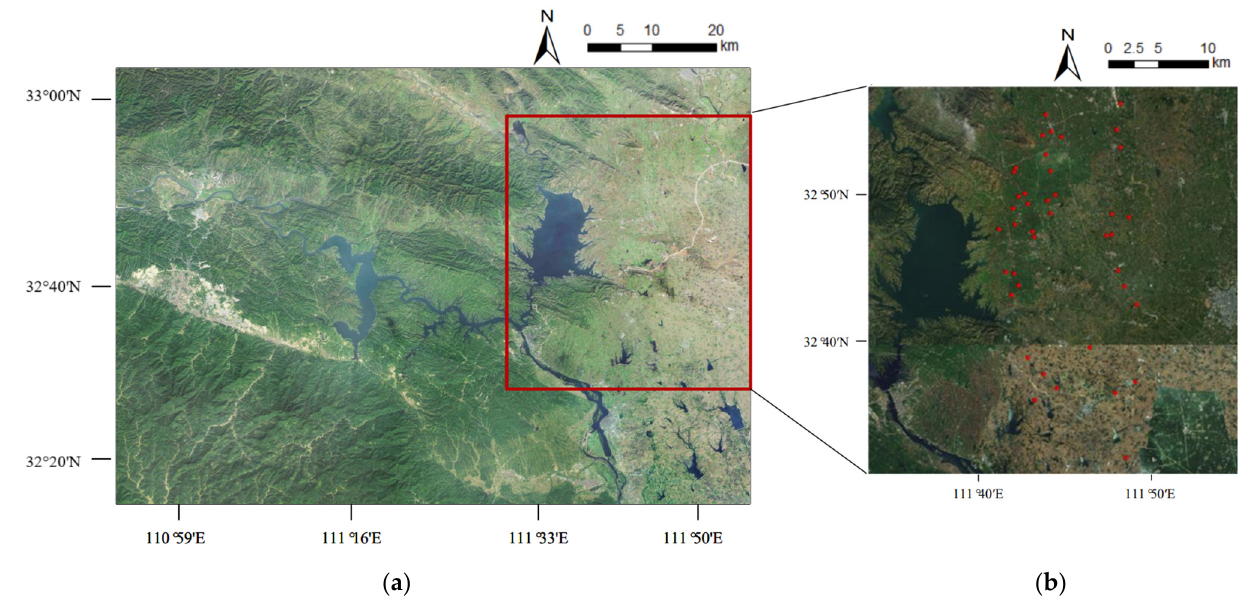
Figure 1. Location of the study area and the sampling points: ( a ) the Danjiangkou ecological service area; ( b ) the study area and sampling points.